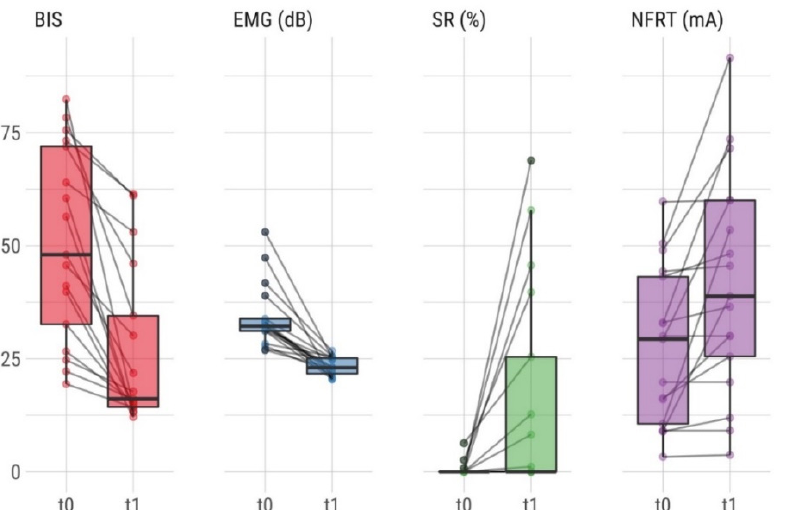
Figure 1. Boxplot showing the distribution of bispectral index (BIS), electromyogram (EMG), sup- pression ratio (SR), and nociceptive flexion reflex threshold (NFRT) before (t0) and after (t1) propofol bolus administration. Horizontal lines indicate changes during individual measurements.